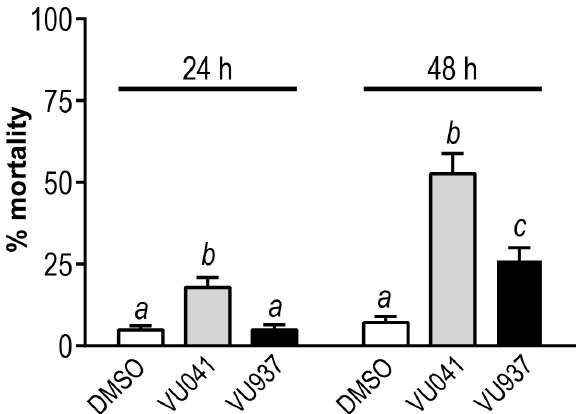
Figure 2. Toxicity of VU041 and VU937 in first instar Ae. aegypti at 24 h and 48 h after addition to the rearing water (dH 2 O). The concentrations of the VU small molecules and DMSO control were 100 µ M and 1%, respectively. Values are means ± SEM based on 42 replicates of six larvae per treatment. Lower-case letters indicate statistical categorization of the means within each time point as determined by two-way repeated measures ANOVA with a Boneferroni’s multiple comparisons test ( p < 0.05).